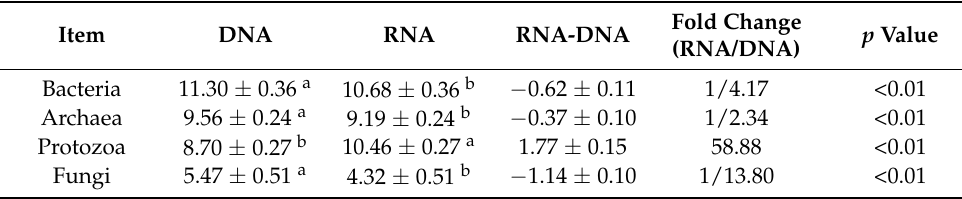
Table 1. Log-transformed marker gene copies (means ± SD, g − 1 rumen content) of the targeted microbial groups at the DNA and RNA level. Item DNA RNA RNA-DNA